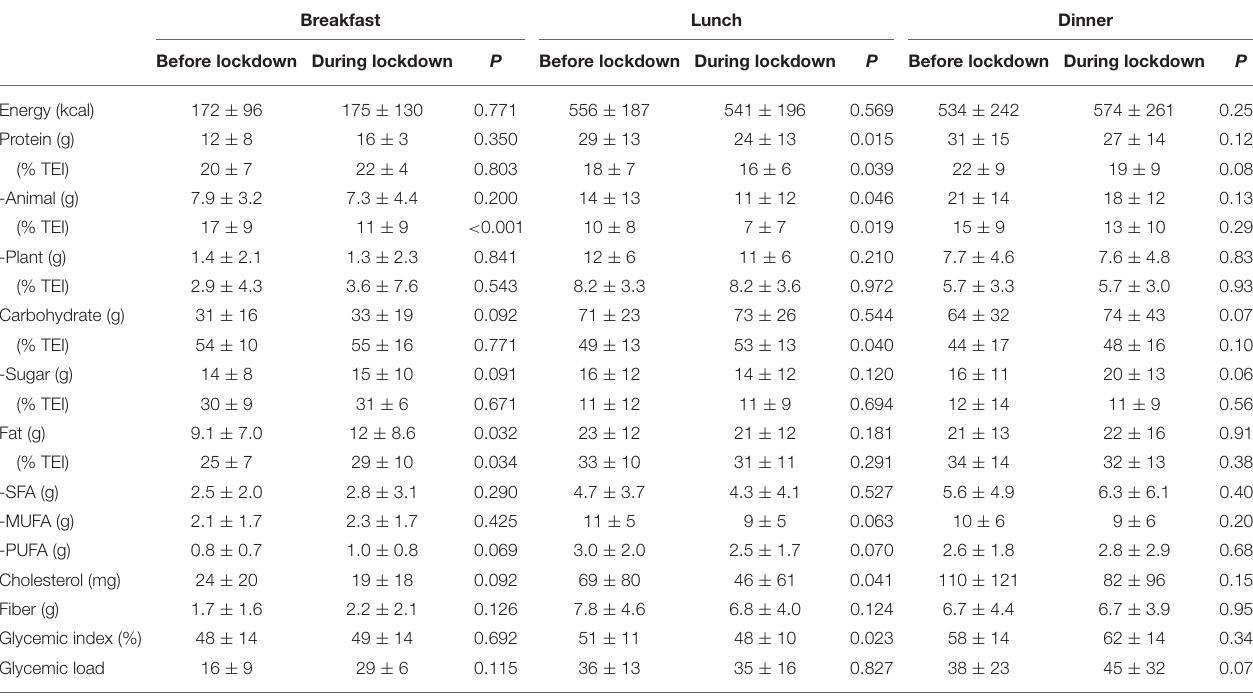
TABLE 3 | Energy intake and dietary composition of breakfast, lunch, and dinner obtained through 7-day food records completed before and during the lockdown in the T1D study participants ( n =